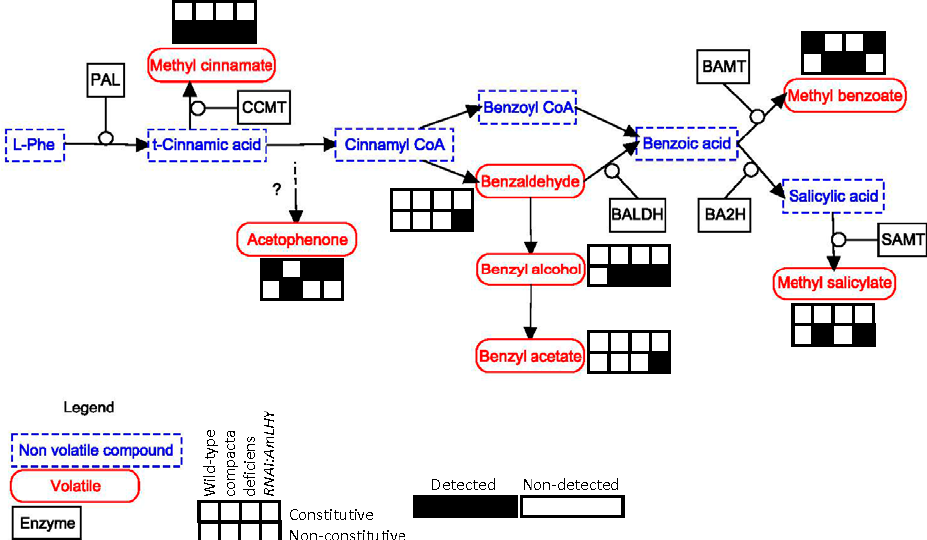
Figure 6. Benzenoid/phenylpropanoids schematic pathway. Detected and non-detected volatiles are shown as follow: first row refers to constitutive profiles and second row to non-constitutive by frequency profiles. Detected compounds are depicted by black and not detected by white. Each column represents a snapdragon group: wild-type (1st), co (2nd) and defnic (3rd) and transgenic lines RNAi:AmLHY (4th). PAL: phenylalanine ammonia lyase, CCMT: cinnamic acid carboxyl methyl transferase, BALDH: benzaldehyde dehydrogenase, BA2H: benzoic acid 2-hydroxylase, BAMT: benzoic acid carboxyl methyl transferase, SAMT: salicylic acid carboxyl methyl transferase.